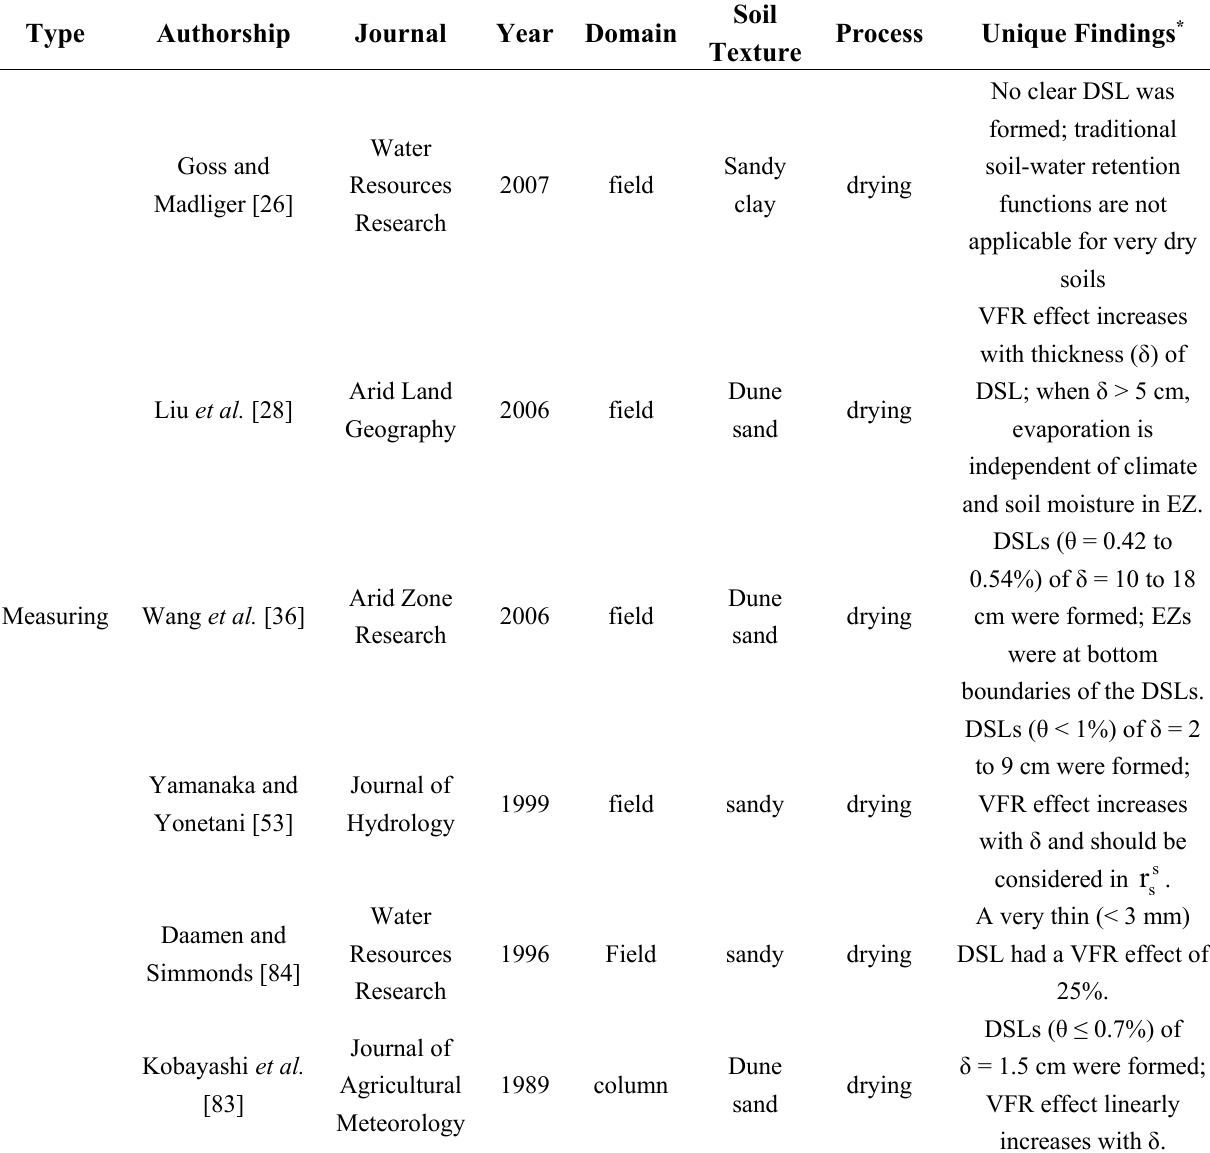
Table 1. List of the representative studies selected for the